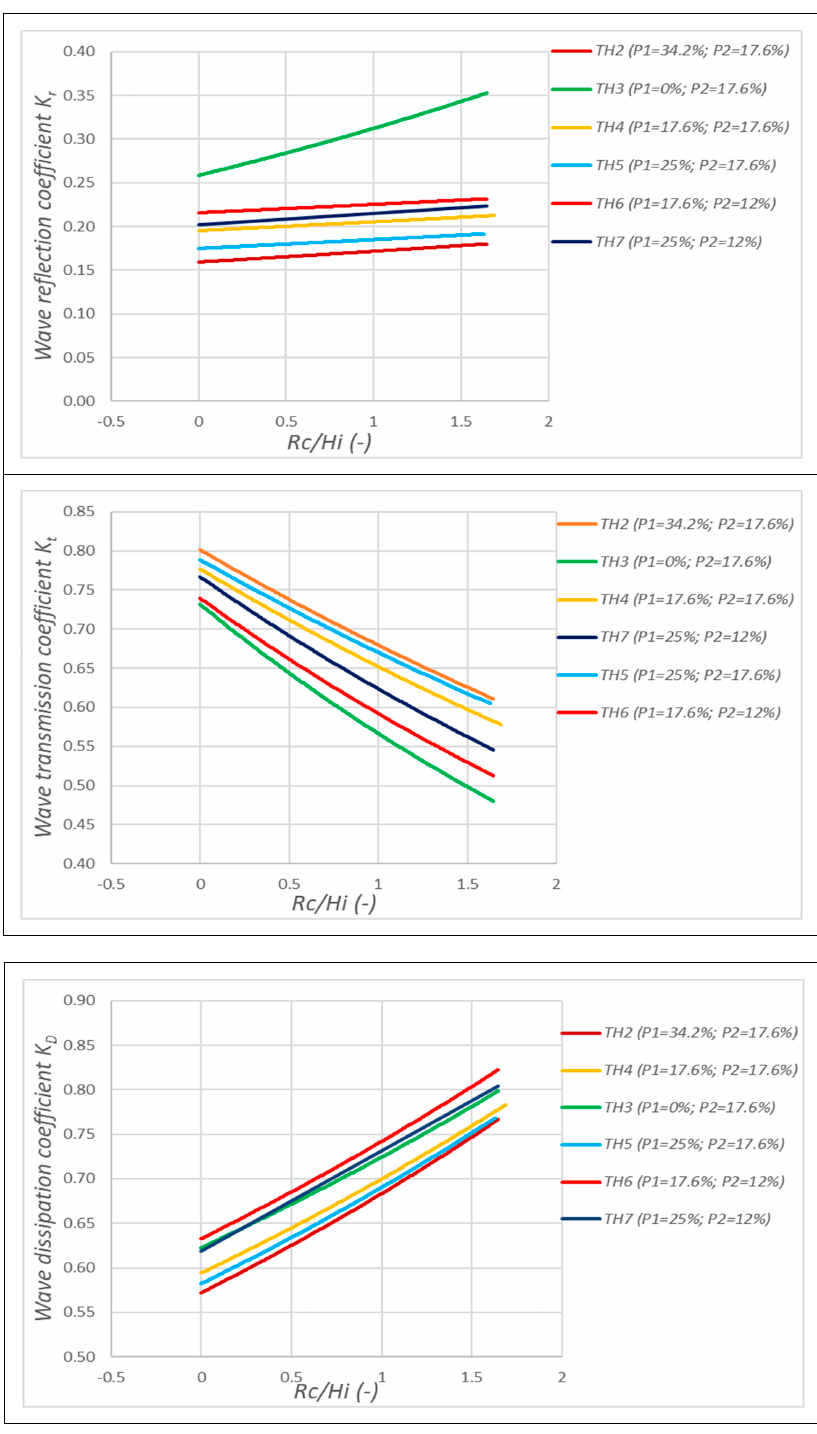
Figure 11. Influence of the crest freeboard of the PTPBW on the coefficients K r , K t , and K D . The wave transmission coefficient